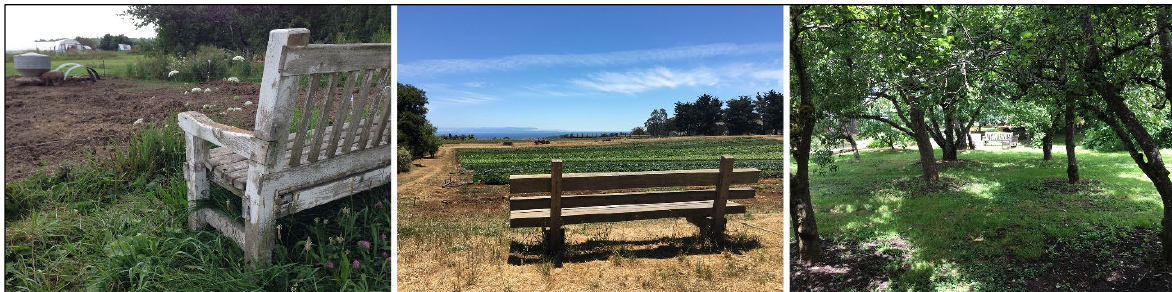
Figure 9. Reflective Seating at Pig Project (Left), Farm Vista (Center), and Memorial Grove